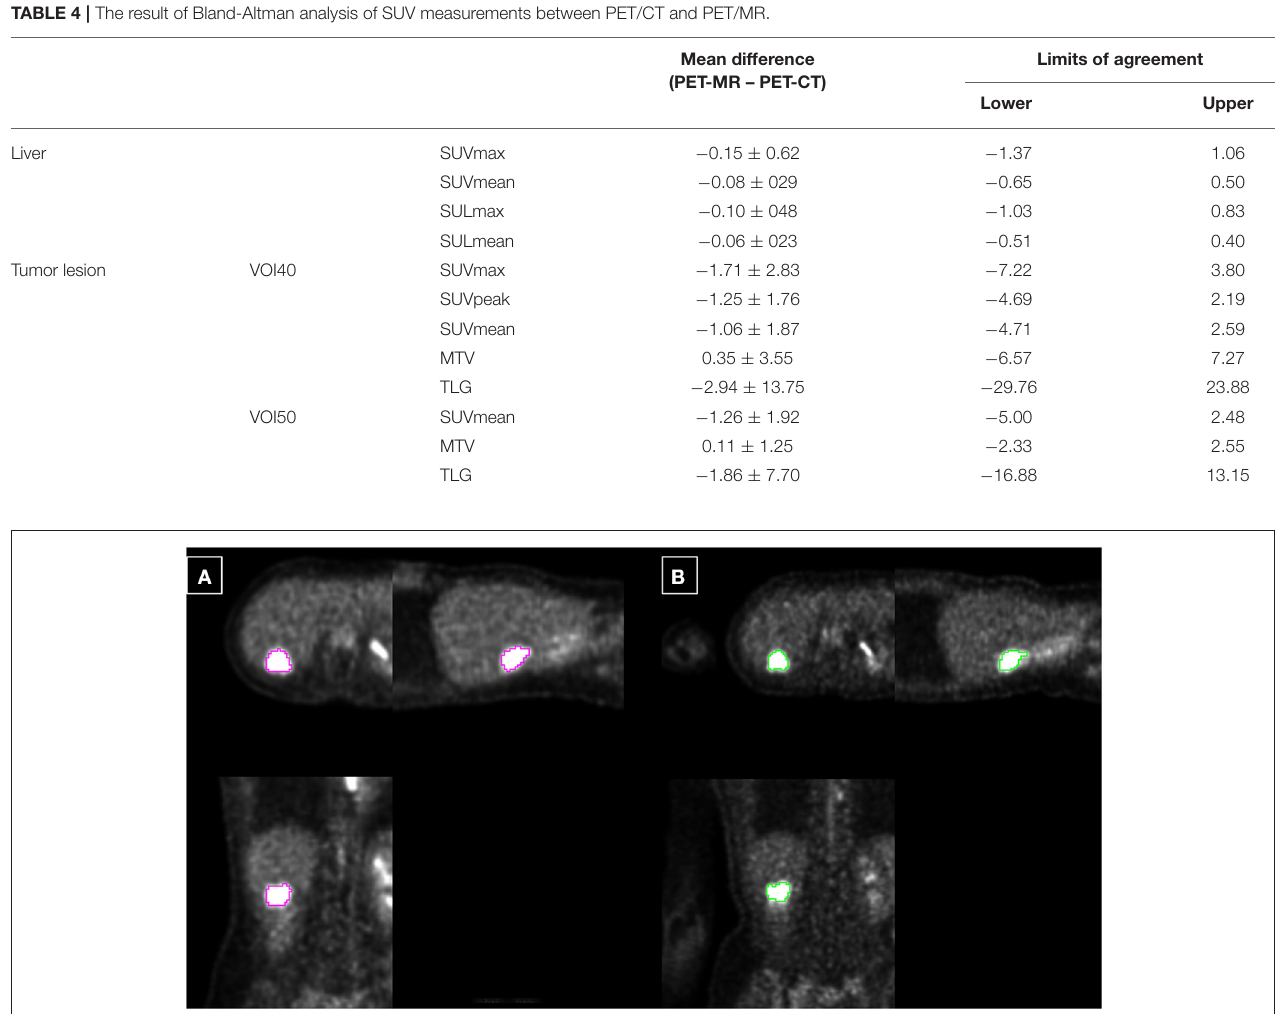
FIGURE 4 | Example 1: 40-year-old female with liver metastasis of breast cancer. Each PET-CT (A) and PET-MR (B) was acquired 72 and 115min after injection. The tumor is delineated based on fixed 40% threshold to